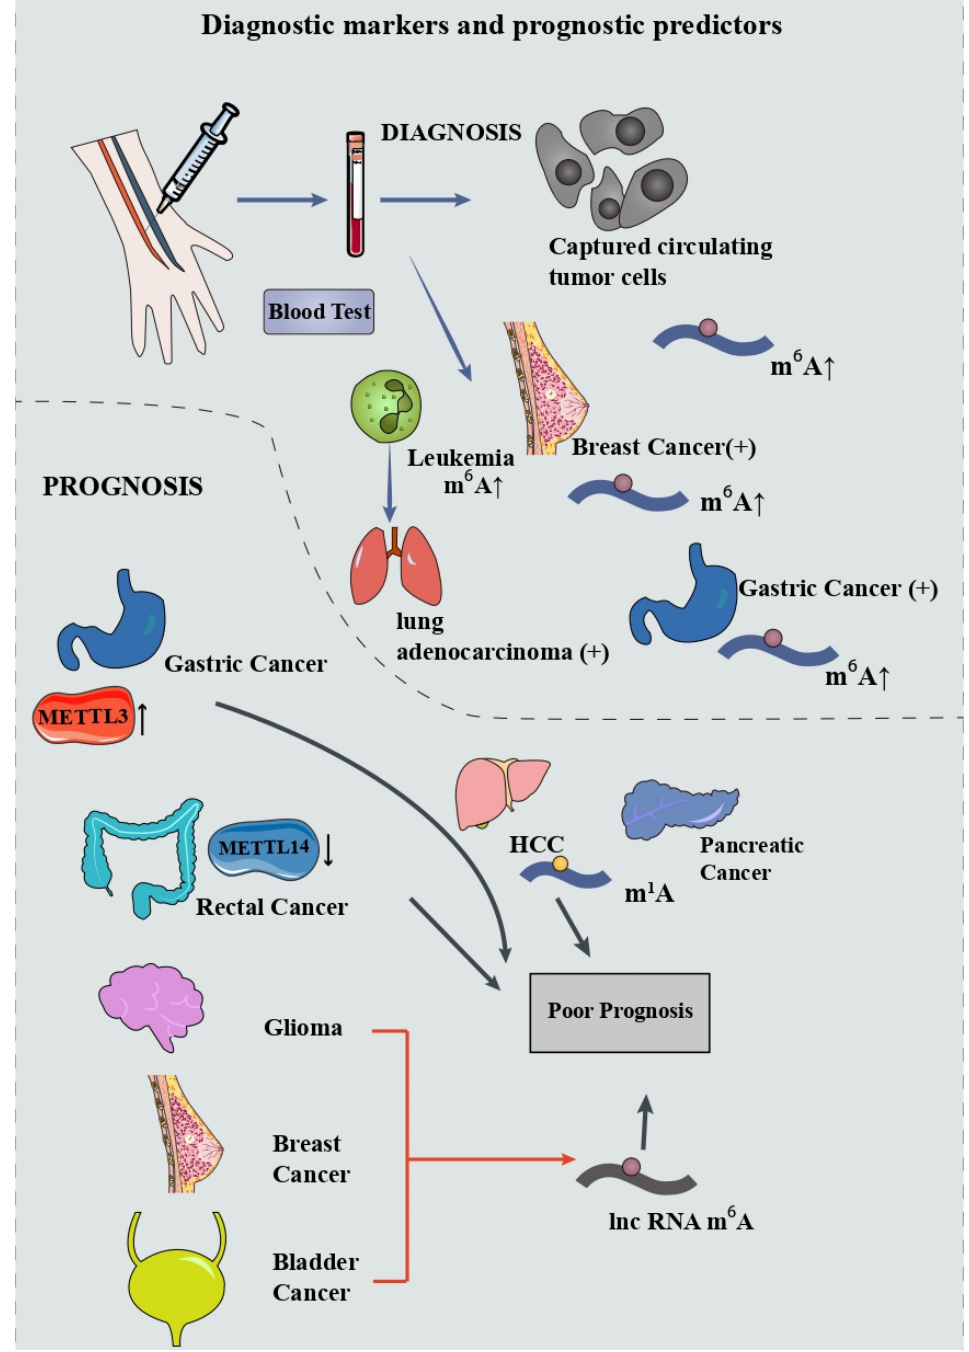
Figure 3. Methyladenosine modifications could act as diagnostic markers and prognostic predictors.